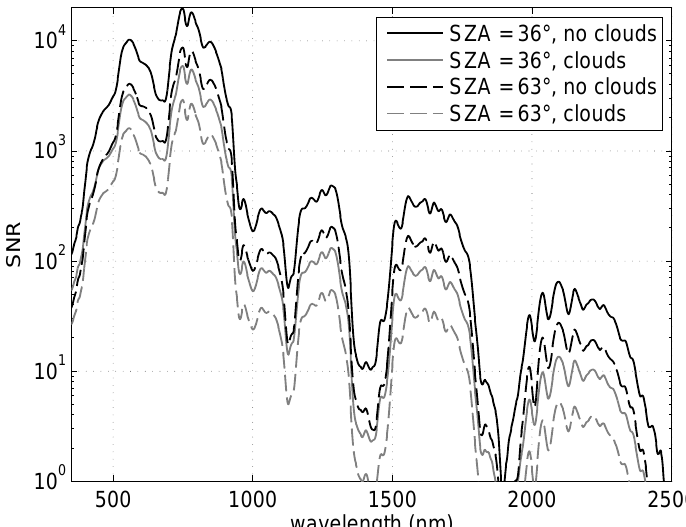
Figure 1. Signal-to-noise ratios for dual FOV measurements using Spectra-Vista HR-1024 instruments and 10 s integration times. Measurements at Leuven, Belgium, 10/9/2008, 14h00 local time (SZA = 36°) and 17h00 local time (SZA =